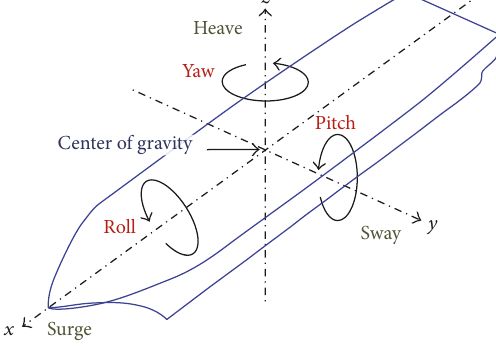
Figure 5: Six-DOF vessel motions [8].